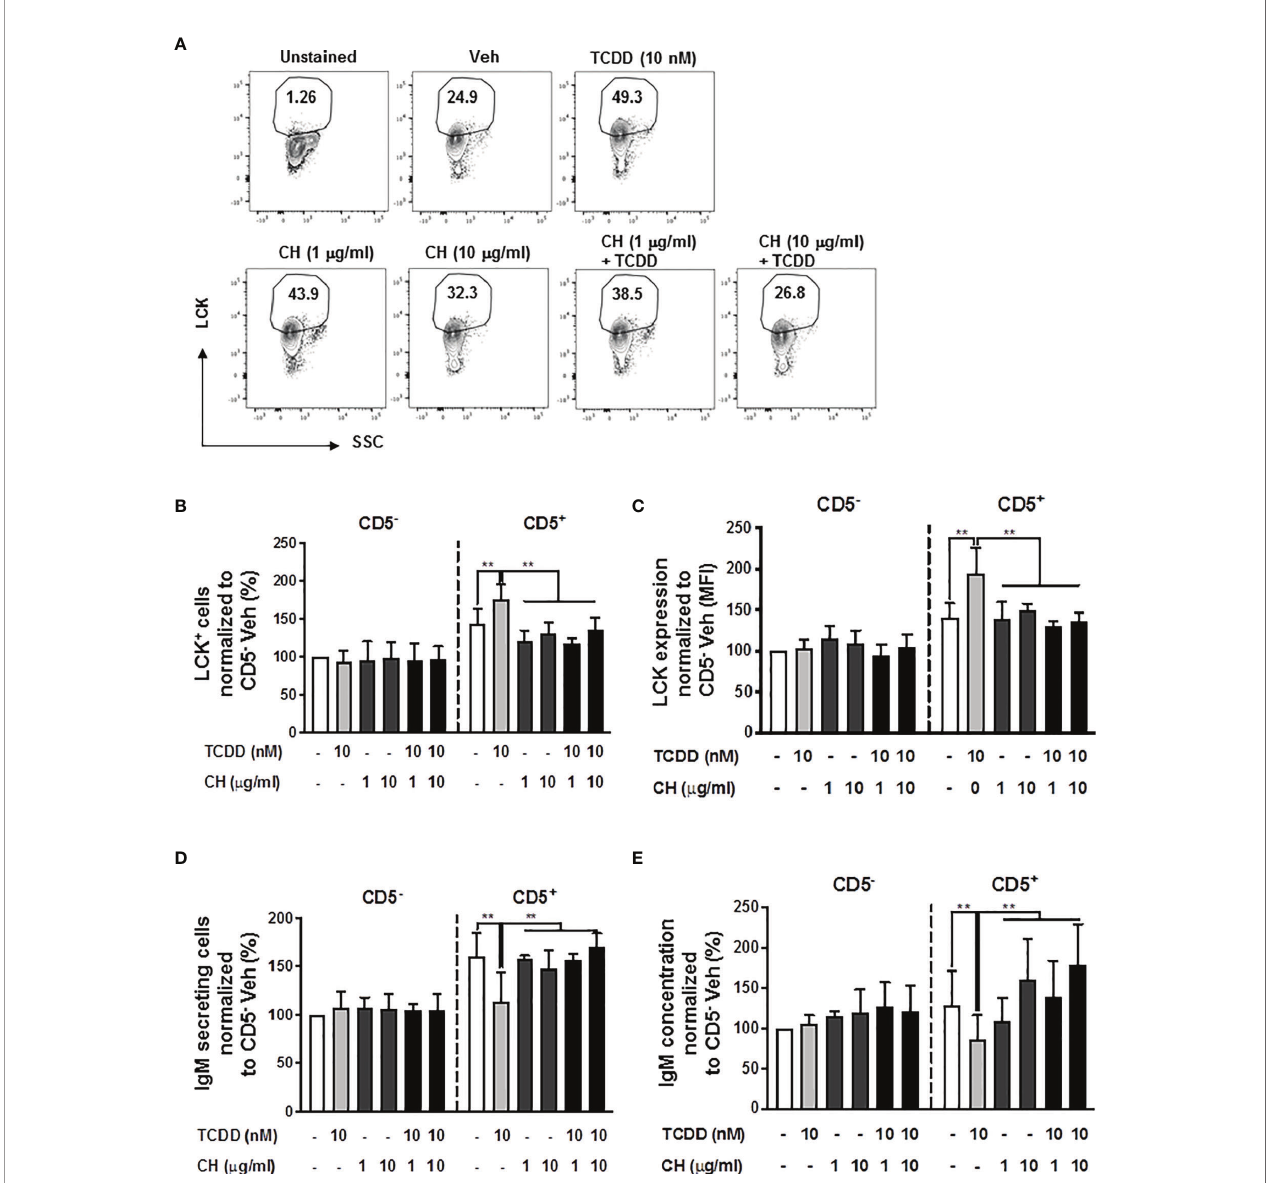
FIGURE 2 | The TCDD-mediated upregulation of LCK and suppression of the IgM response in CD5 + ILBs is blocked by AHR antagonist treatment. Human CD5 +/- B cells were pre-treated with 1 or 10 m g/ml of AHR antagonist (CH-223191 abbreviated as CH), for 30 minutes and then followed by activation and treatment with Veh (0.02% DMSO) or TCDD (10 nM) on day 0 and cultured for 7 days as previously described. (A) Representative fl ow cytometry plots of CD5 + ILBs with or without AHR agonist and/or antagonist treatment; (B) Percentage of LCK + cells; (C) Mean fl orescence intensity (MFI) of LCK in CD5 +/- populations; (D) Number of IgM secreting cells; and (E) IgM concentration within CD5 +/- populations with Veh or TCDD treatment. Determinations were made using B cells from 6 human donors (N = 6) from 2 independent experiments. Data were normalized to the CD5 - Veh control group. Signi fi cant differences are indicated by ** p < 0.01 (two-way ANOVA following with Fisher ’ s LSD post hoc